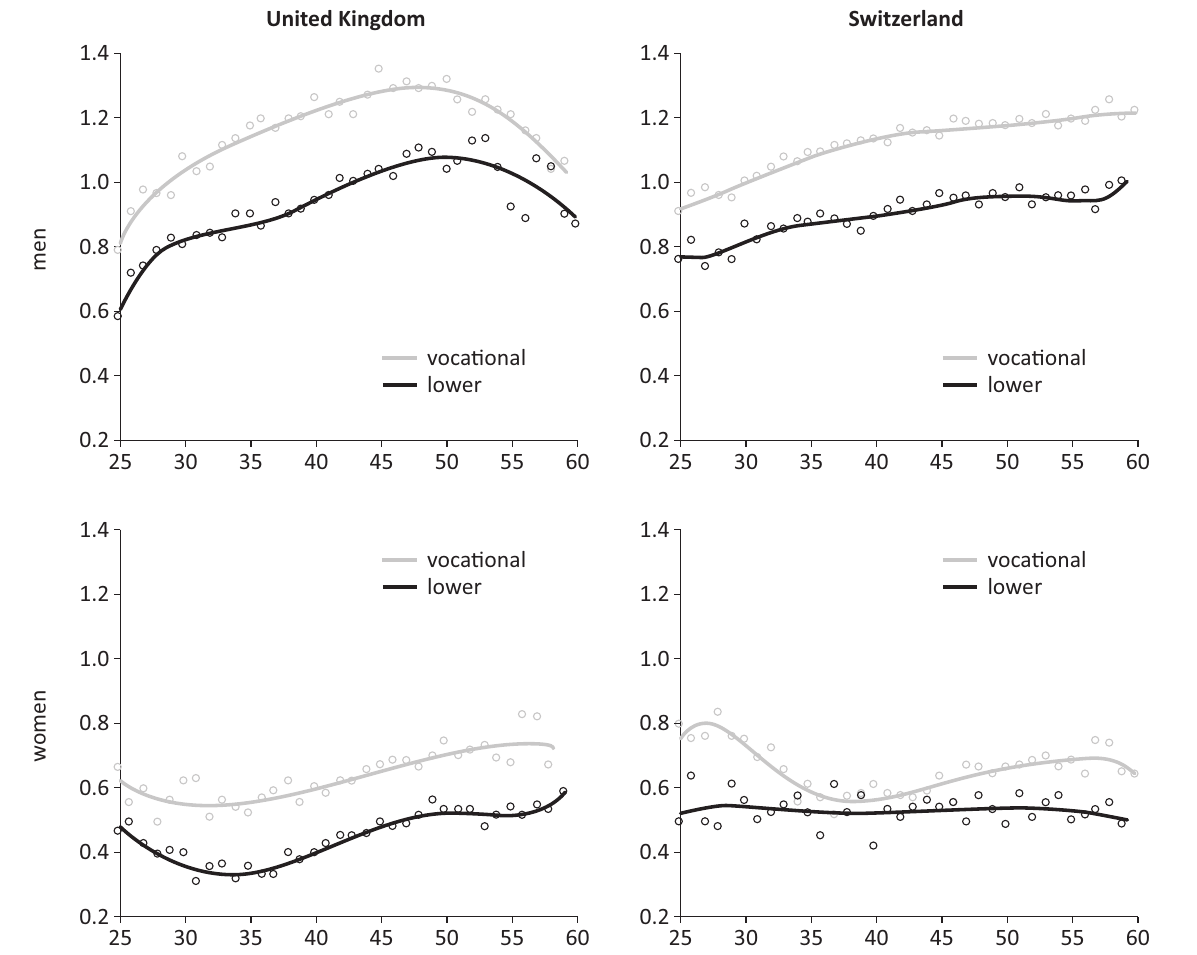
Figure A6. Median annual work income for men and women by level of education: upper-secondary vocational education ( vocational ) and compulsory school level or lower ( lower ). Source: UK Labour Force Survey 1993–2014 and Swiss